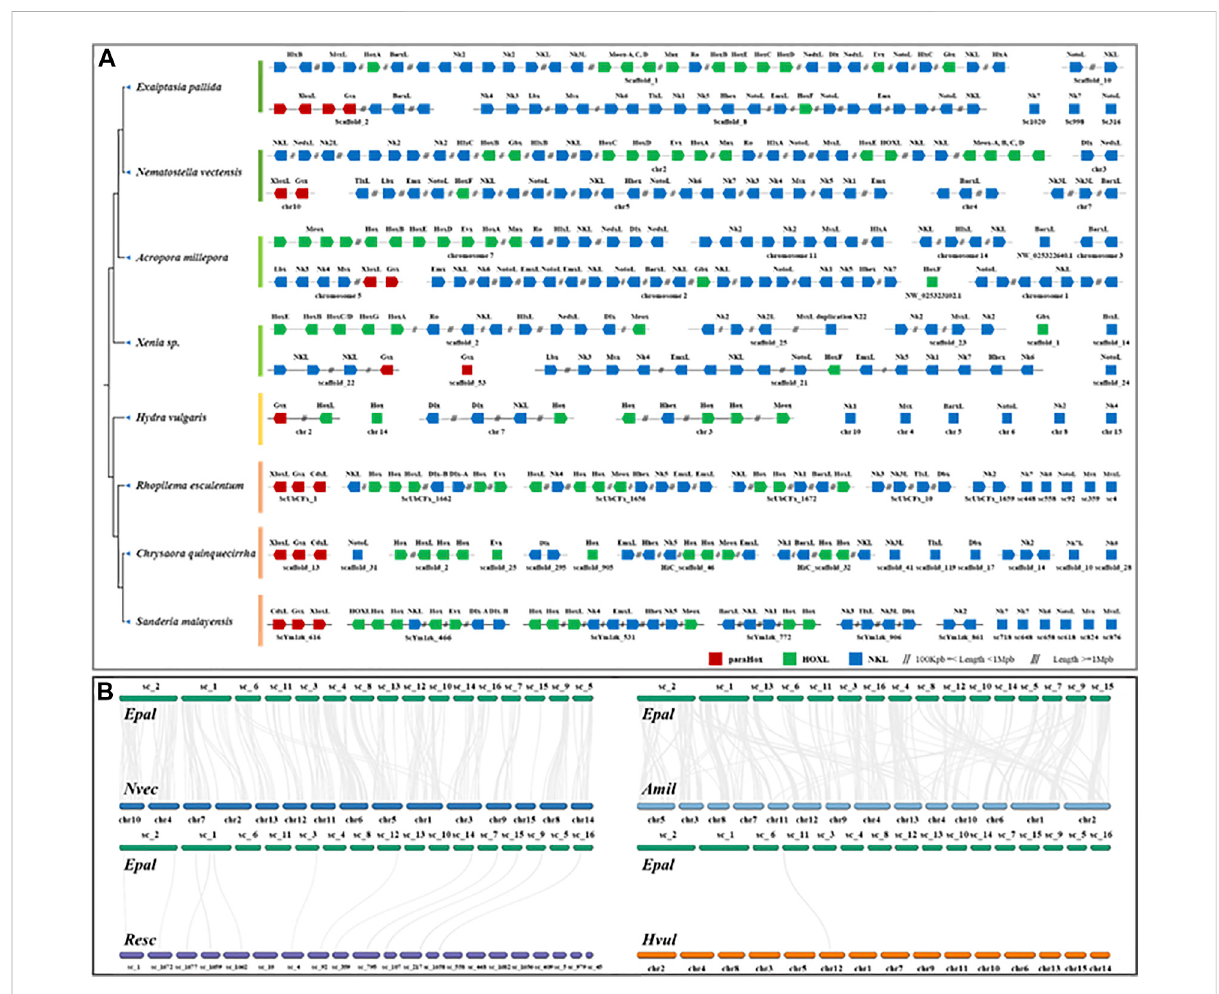
FIGURE 2 (A) Chromosomal organization of ANTP-class homeobox gene arrangement in cnidarian genomes. (B) Syntenic relationship